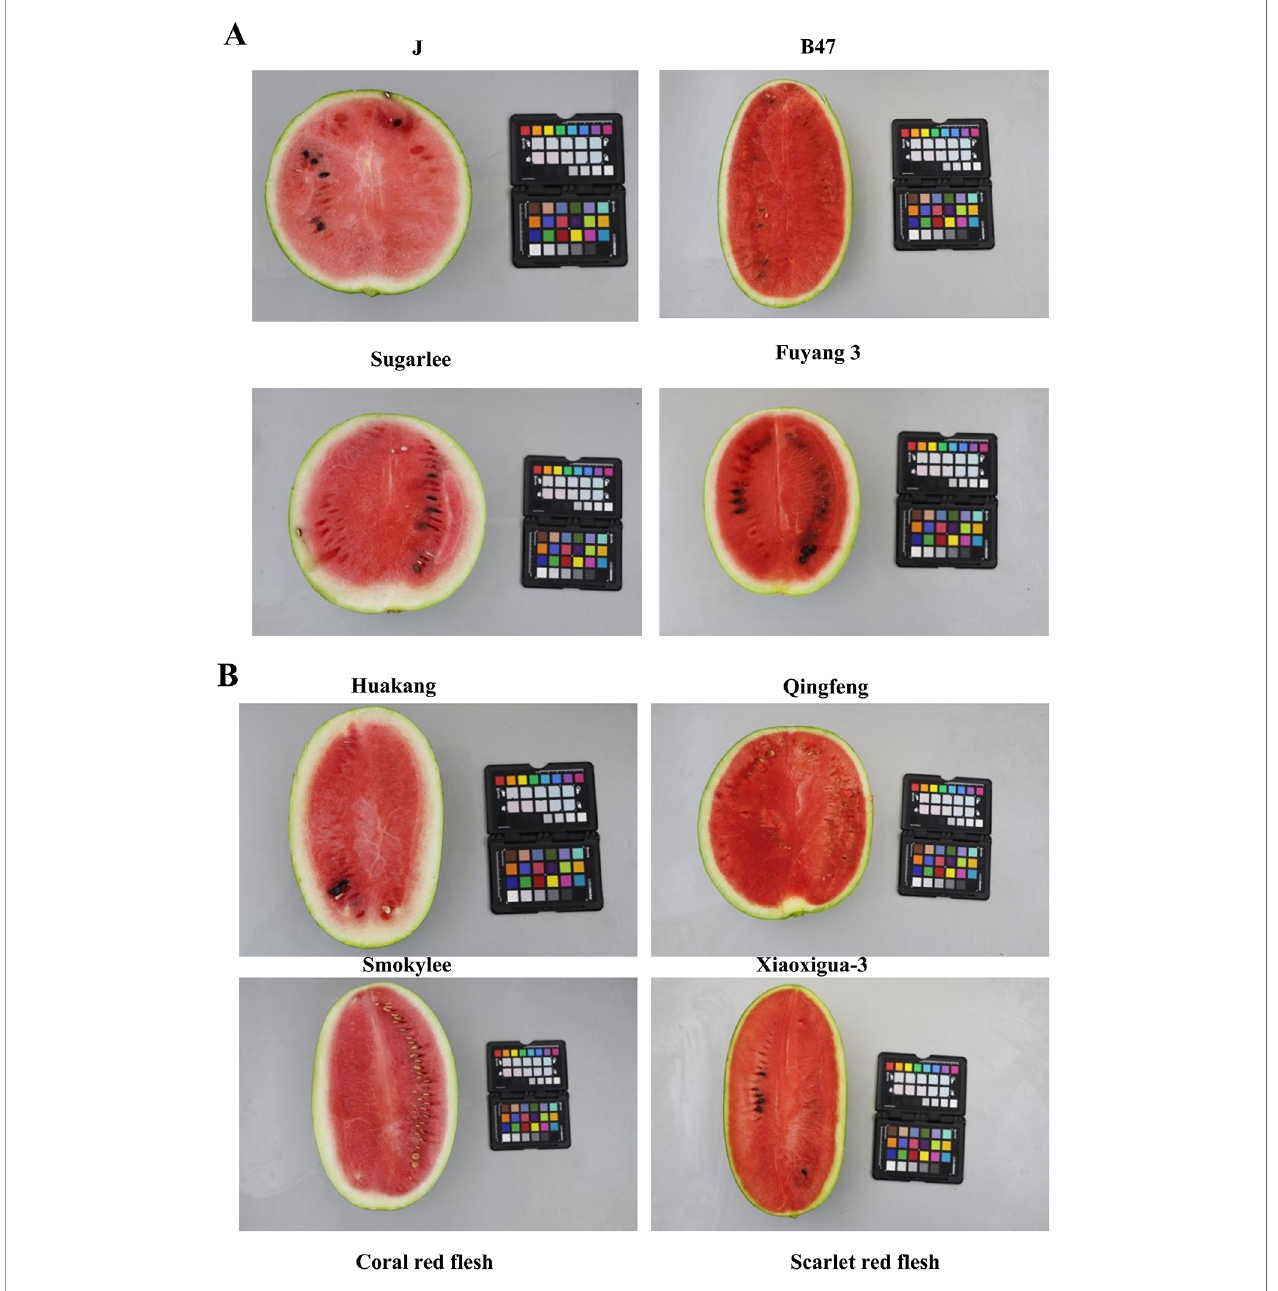
FIGURE 5 | Photographs of longitudinal cross-sections of the parental lines and [the fi rst line of (A) ] a selection of the watermelon accessions with classic coral red- and scarlet red- fl eshed color [the second line of (A) and (B) ]. Left was the corel red- fl eshed lines and right was the scarlet red- fl eshed